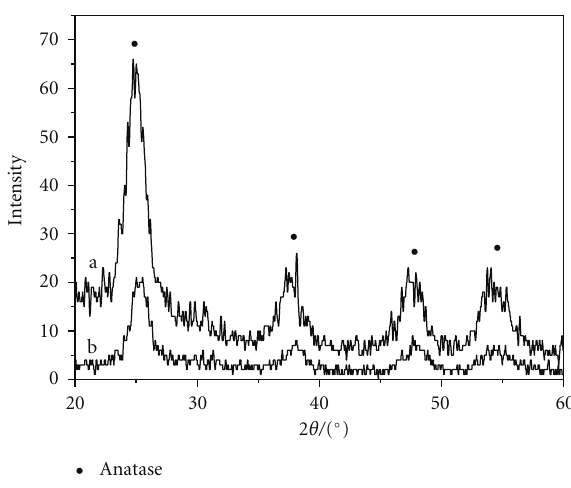
Figure 5: XRD spectra of TiO 2 (a), APTMPP-MPS-TiO 2